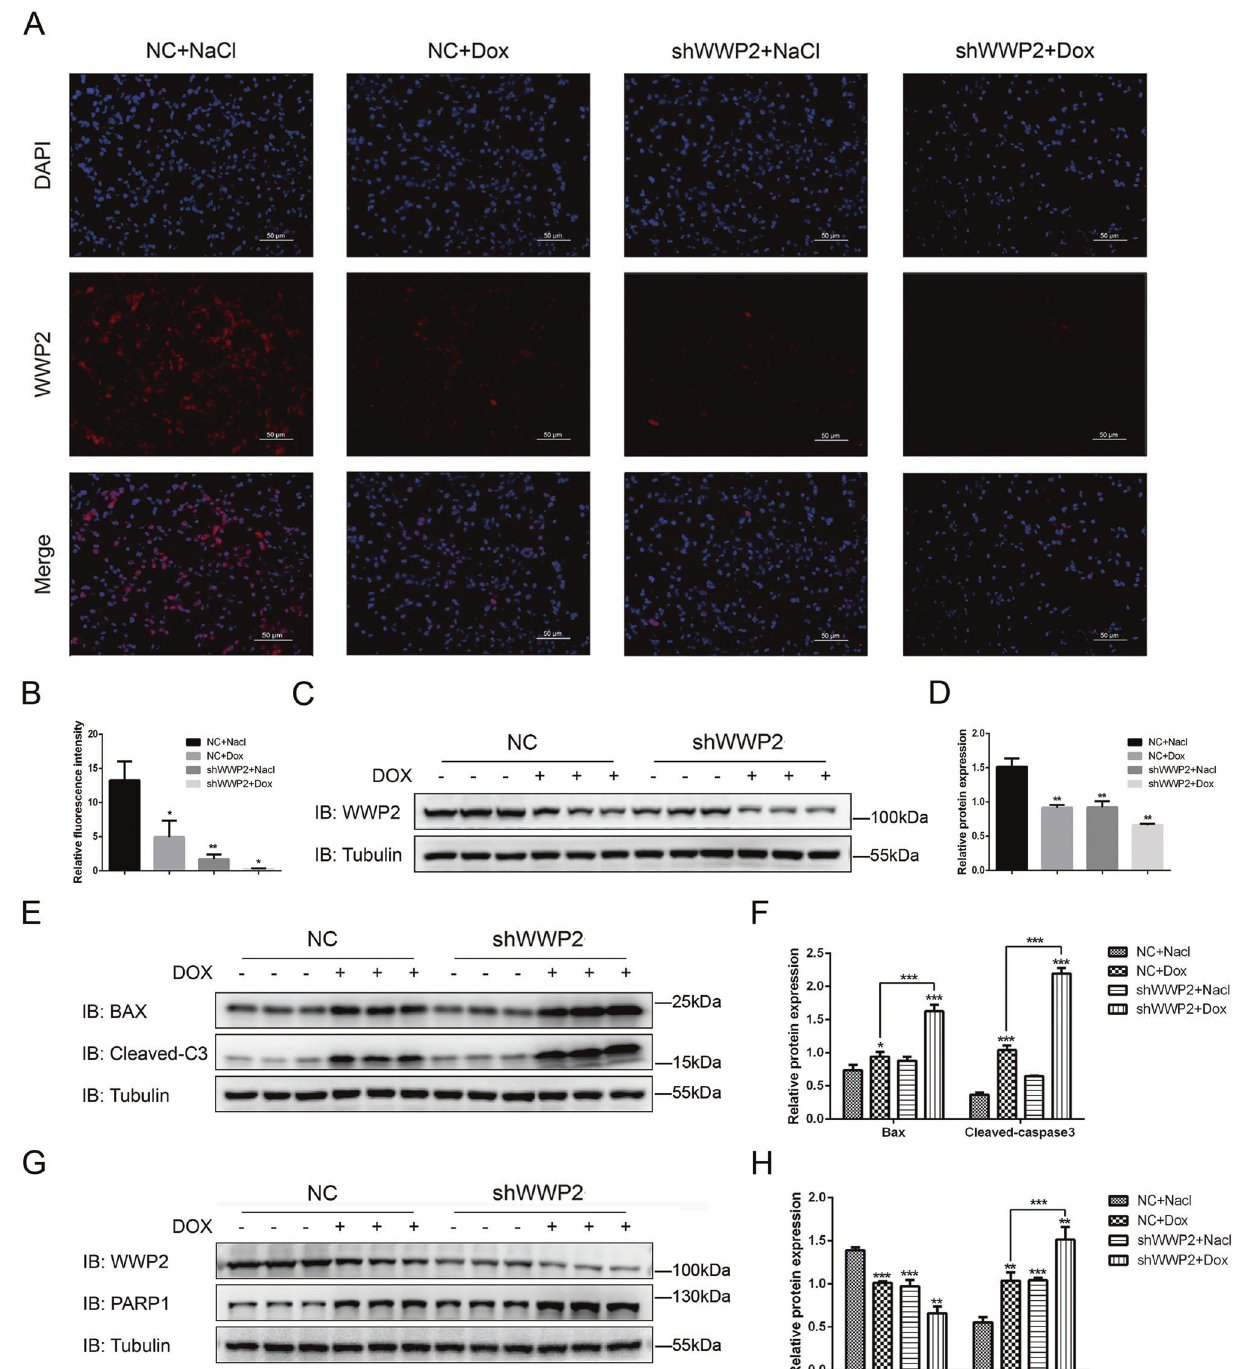
Fig. 2 Knockout WWP2 enhances apoptosis level under inducement of Dox and WWP2 negatively regulates PARP1 stability in ALL xenograft tumor. A , B Immuno fl uorescence assays (WWP2 red; DAPI blue) was used to assess WWP2 expression level in different groups of xenograft tumors (scale bar 50 μ m). Data were shown as mean ± SD (* p < 0.05, ** p < 0.01; unpaired Student ’ s t test). C , D Western blot was used to assess WWP2 expression level in different groups of xenograft tumors. Data were shown as mean ± SD (* p < 0.05, ** p < 0.01;